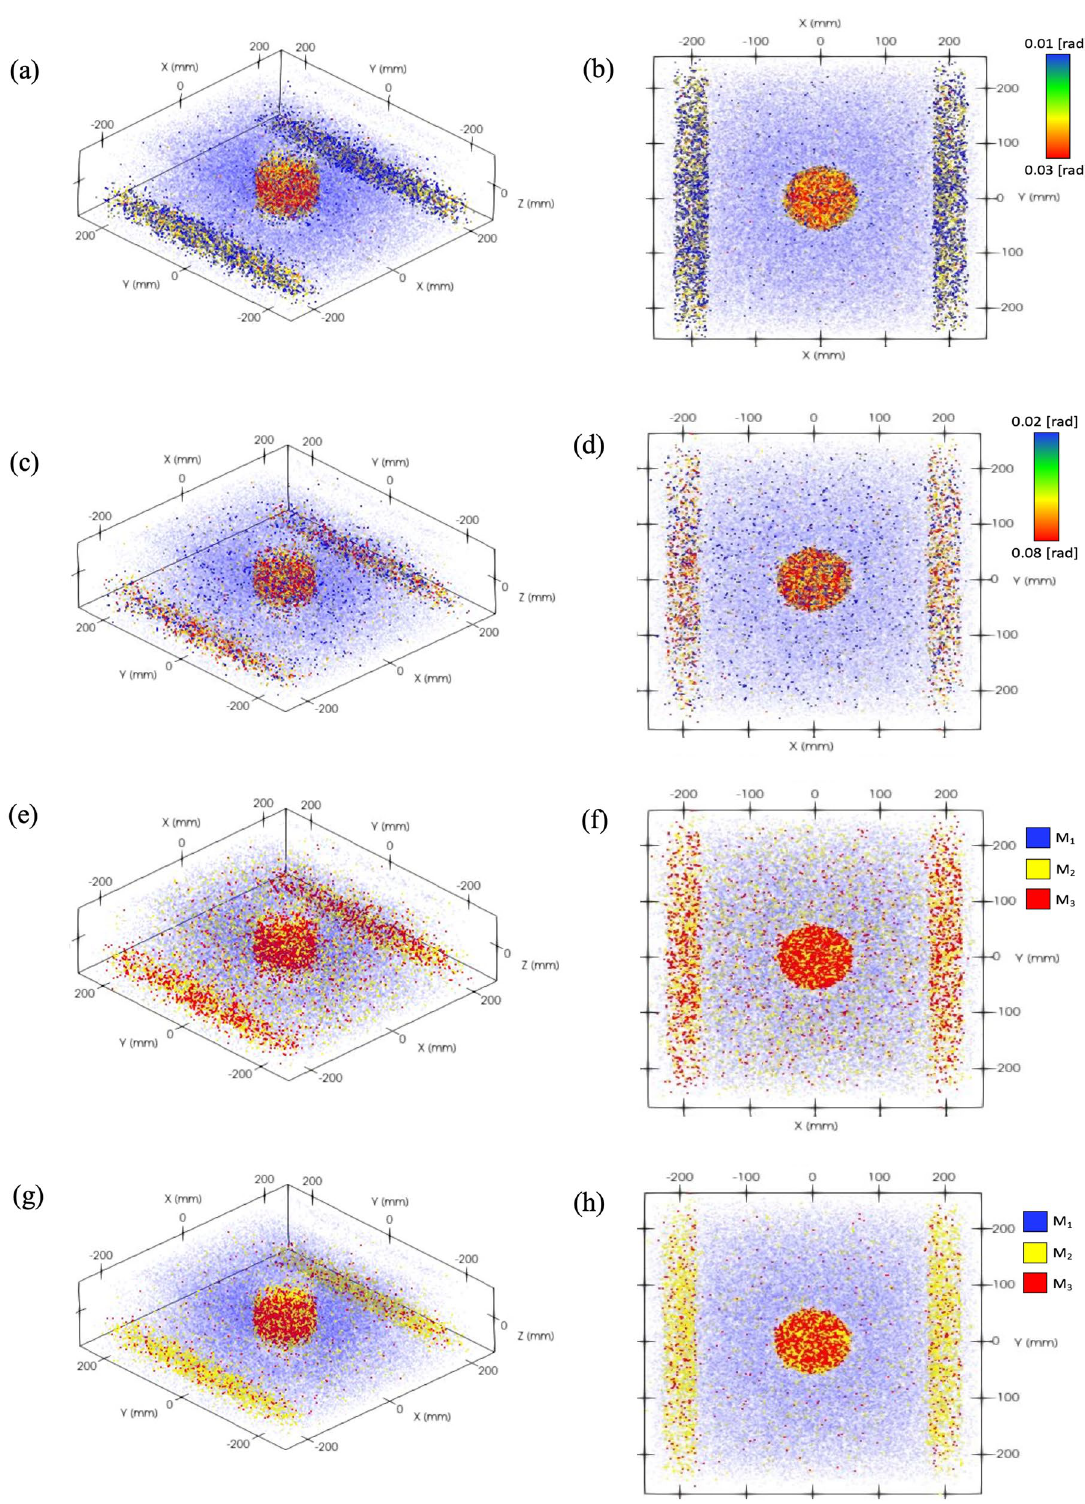
Figure 9. Reconstructed images using a modified PoCA. The results of image reconstruction using muon tomography (a cylindrical tungsten and two steel beams) for four scenarios using original PoCA ( a – d ) and mPoCA ( e – h ): 10 5 mono-energy muons, 3 GeV ( a, b ), (ii) 10 5 muons with cosmic muon spectrum ( c, d ), (iii) 5 × 10 4 muons ( e, f ), and (iv) 10 5 muons ( g, h ) with cosmic muon spectrum. It is noted that continuous and discrete color maps are used for PoCA and mPoCA, respectively. Types of materials are indistinguishable when muon momentum knowledge is not